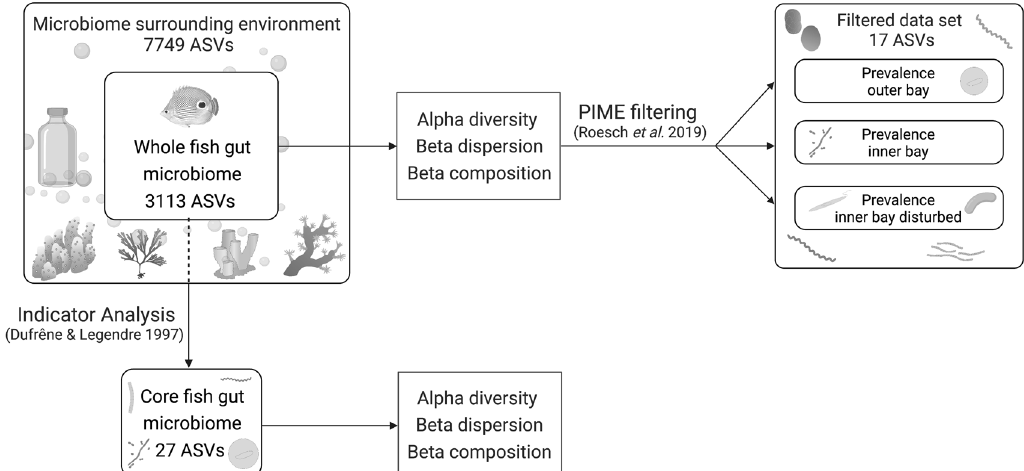
Fig. 7 Microbial community analysis. Microbial community analysis work fl ow illustrating how we subsetted the whole fi sh gut microbiome dataset to delineate the core gut microbiome and gut microbial communities by zone, respectively. To identify the core microbiome, we used indicator analysis 117 between the whole fi sh gut microbiome and the environmental sample fraction consisting of samples of potential fi sh prey taxa and the surrounding seawater. Diversity analysis was done for the whole and core fi sh gut microbiome, respectively. The whole fi sh gut microbiome was fi ltered for prevalence with a machine learning-based algorithm (PIME) 134 to detect community differences among zones that re fl ect fi sh-microbiome responses to the habitat gradient. Created with BioRender.com. The fi sh icon is adapted from a color photograph of Chaetodon capistratus obtained from